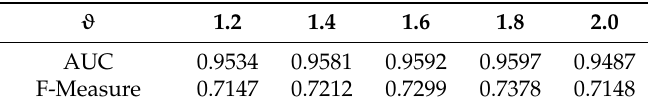
Table 7. Comparison results of different ϑ